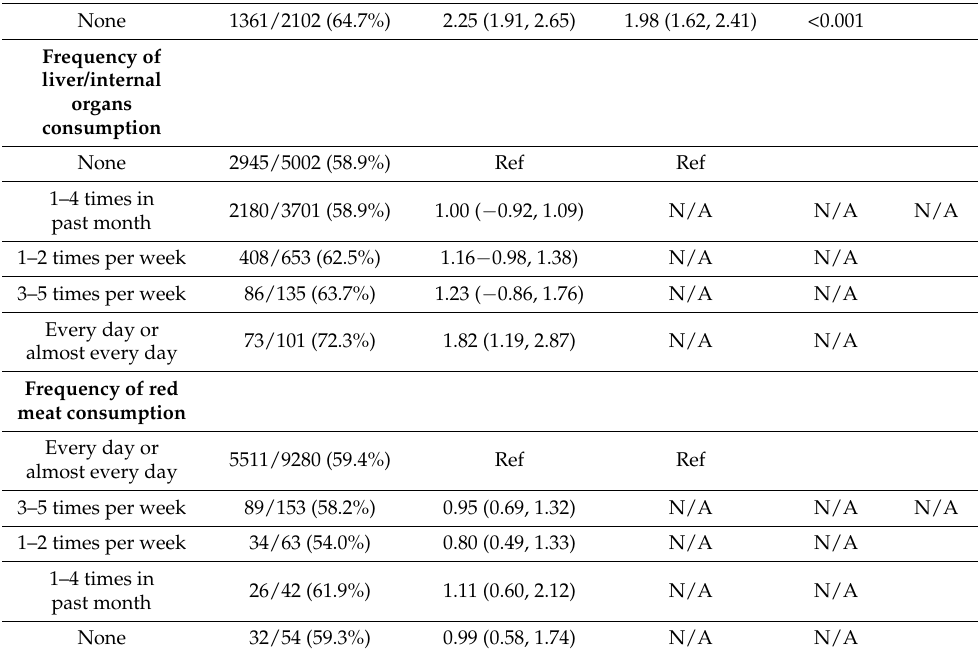
Univariate Analysis